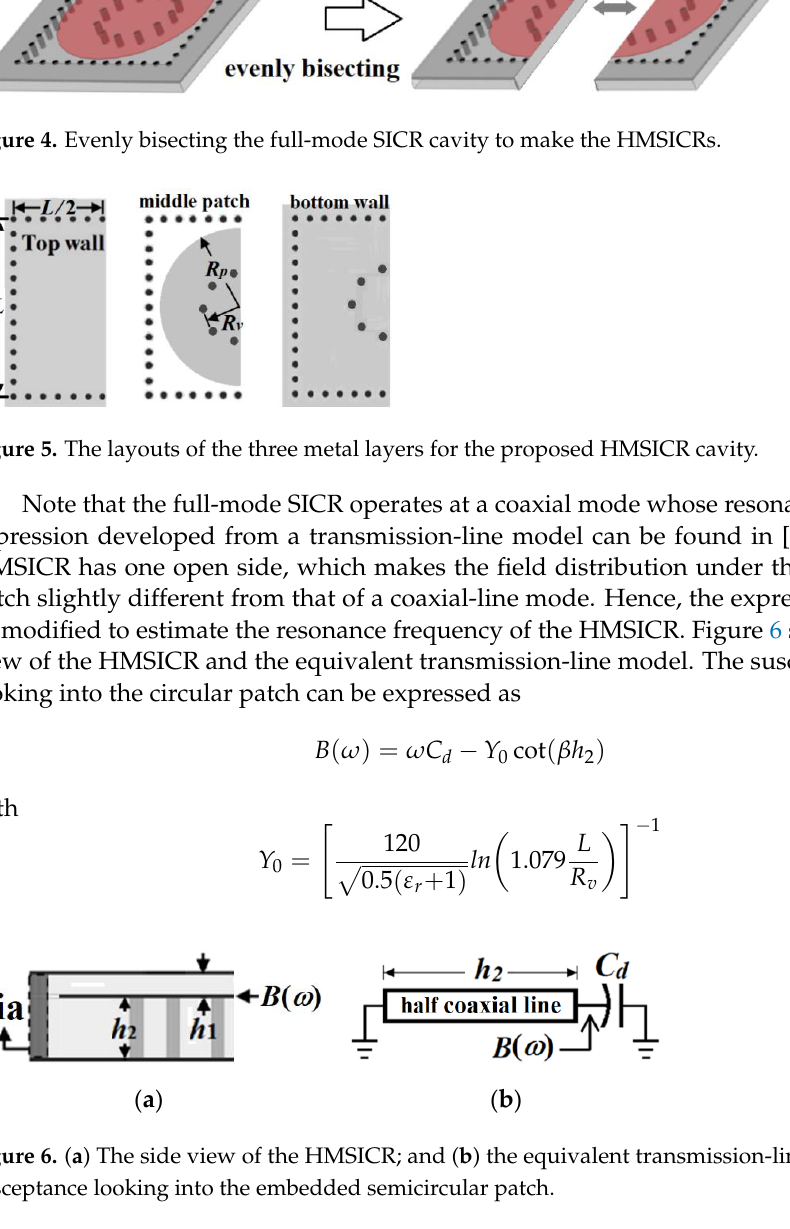
Figure 3. The simulated curves of the normalized resonance frequency f r / f 0 vs. the dimension ratios of R p / L and R v /L (with fixed L = 24 mm).